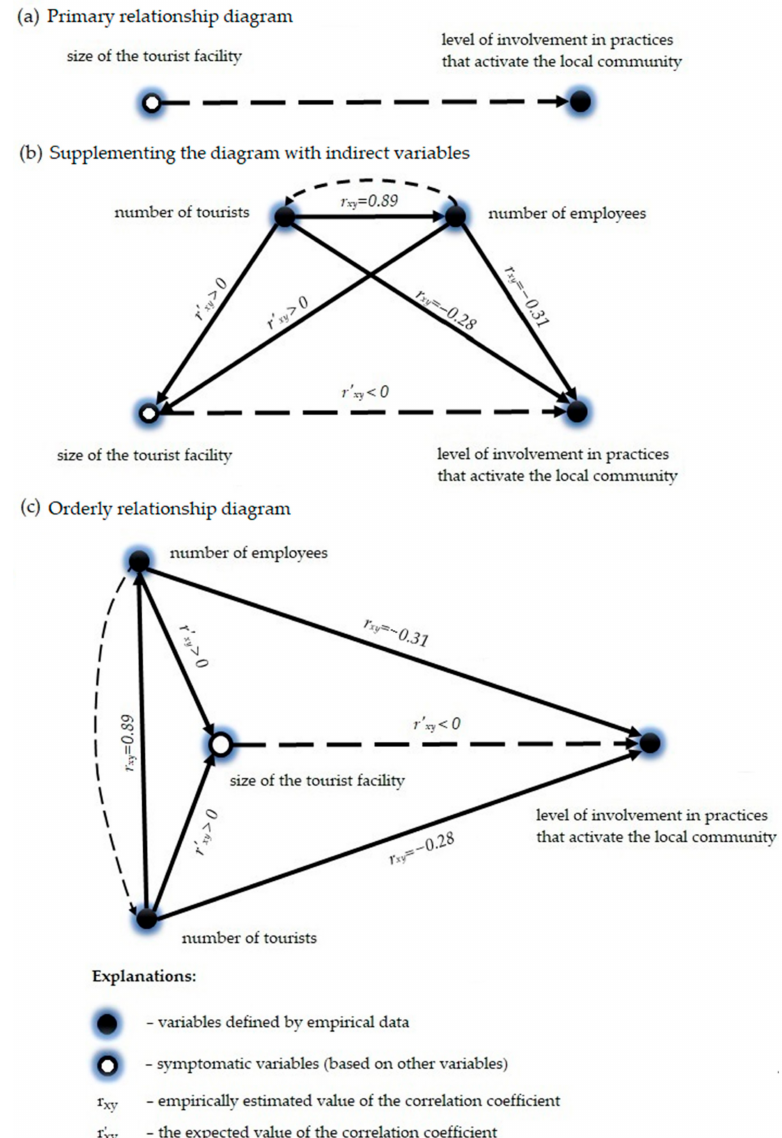
Figure 2. An attempt to develop a causal